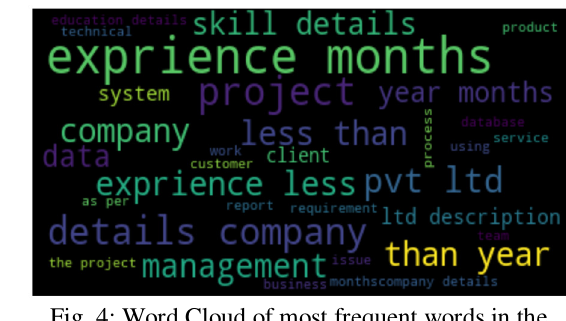
Fig. 4: Word Cloud of most frequent words in the cleaned